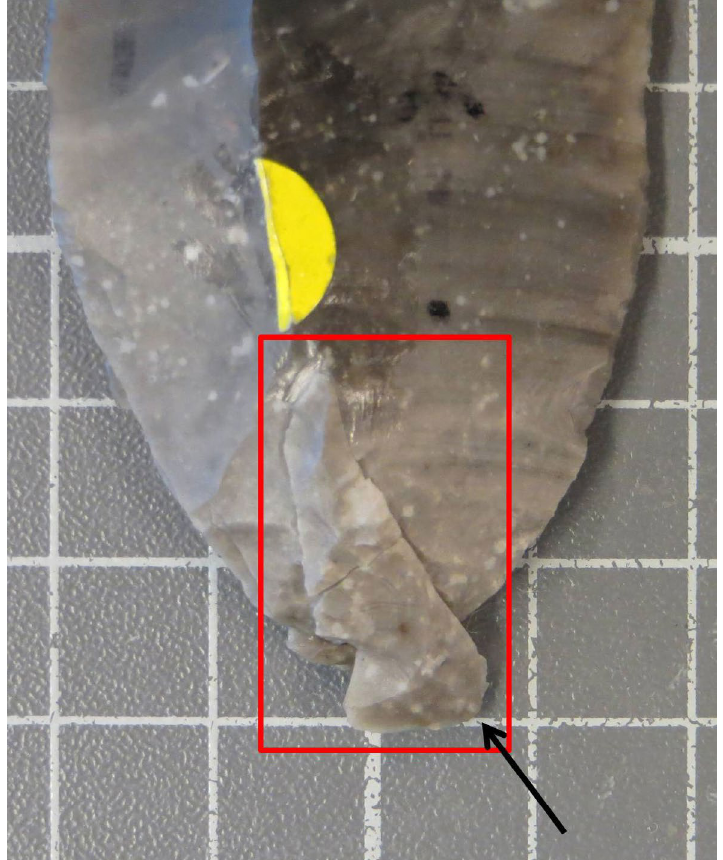
Figure 12. Blade-point 5.19, flake d4 and d6 with the black arrow indicating direction of removal blow (photograph by the author). Gridlines on this image are 10mm